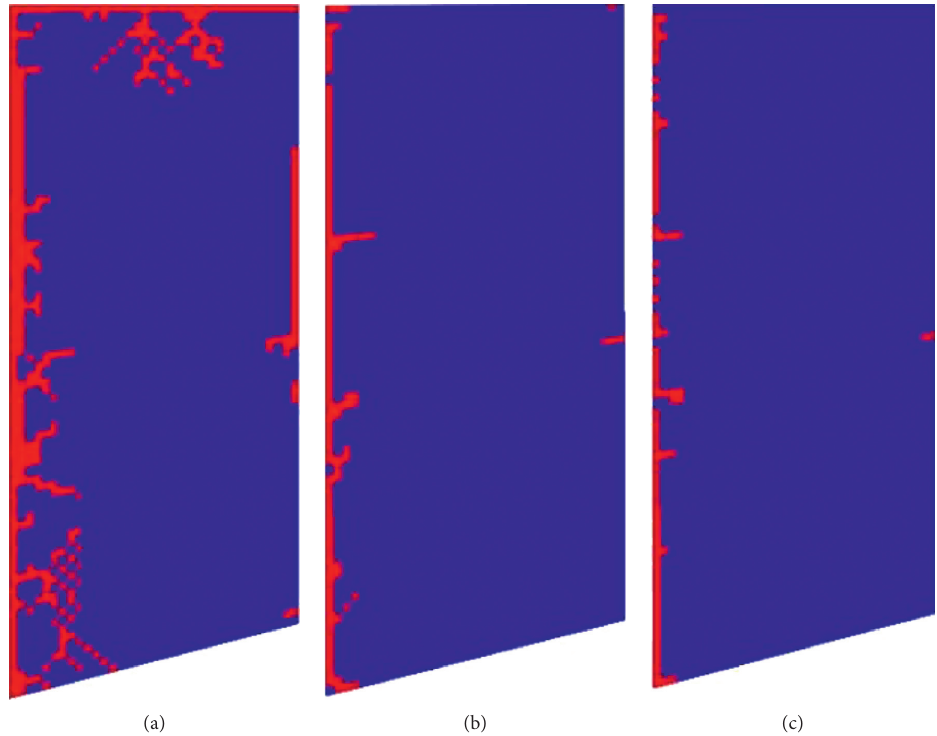
Figure 17: Comparison of the simulation results of web cracking under different working conditions. (a) h h en � 100%.